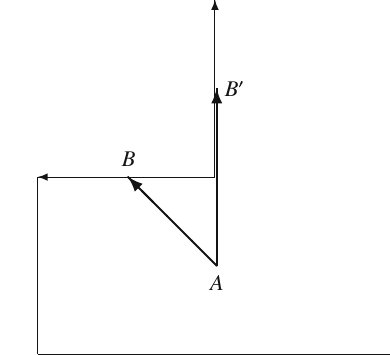
Fig. 15 Structure of the spatial part for C = 3 arrows and glue the space there Fig. 16 Structure of the spatial part for C = 5 arrow and glue the space there